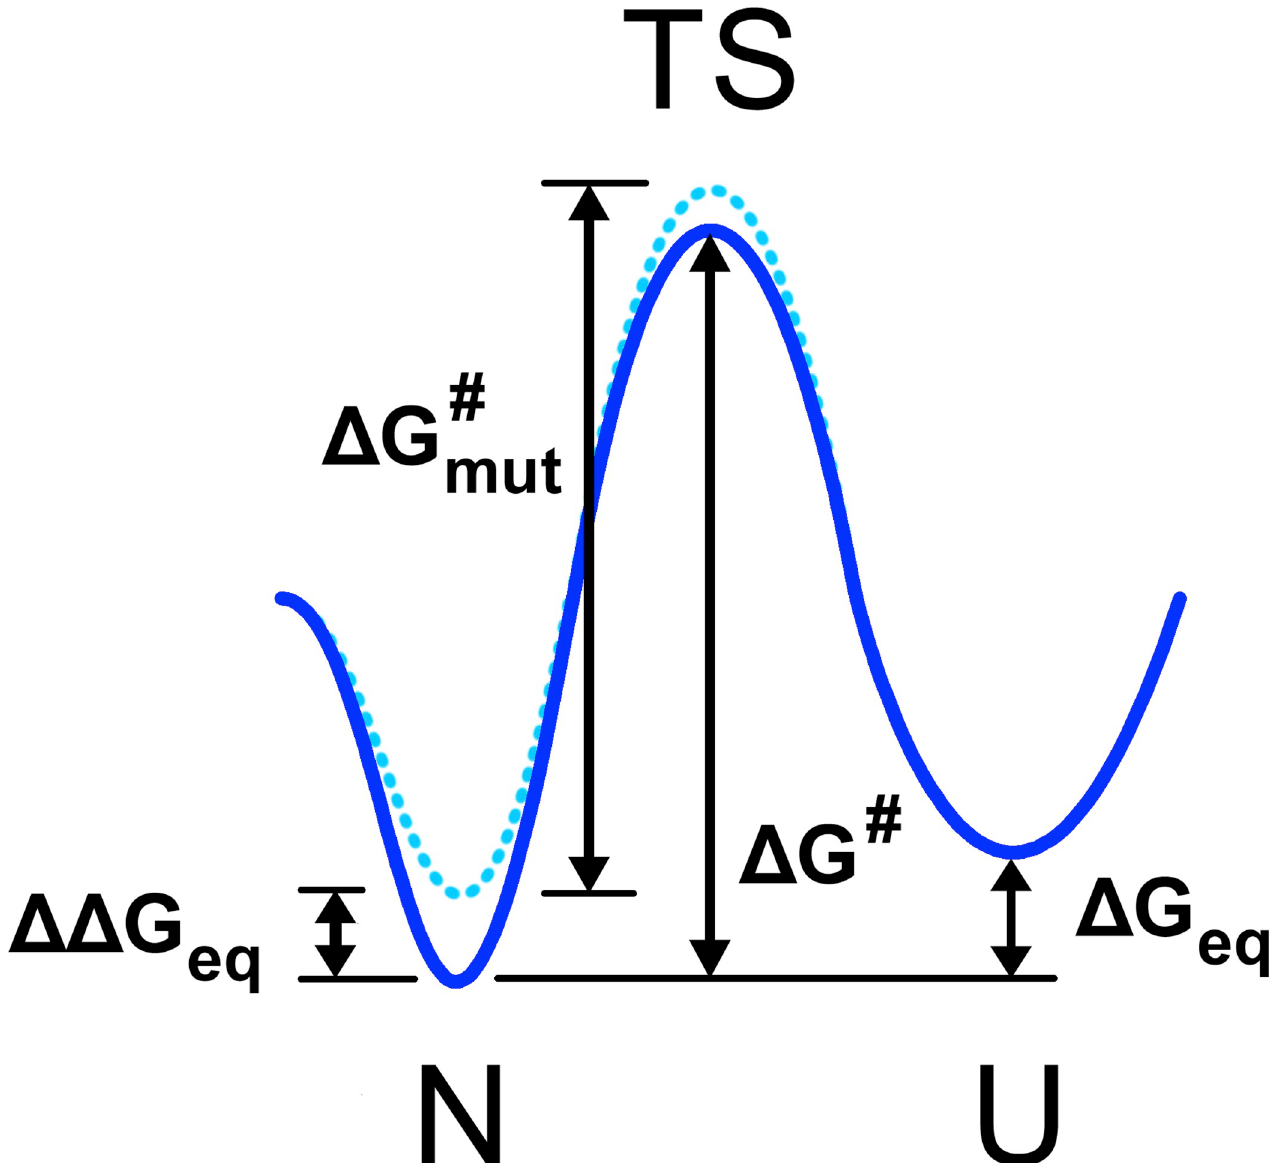
Fig 1. Two state diagram depicting the protein native state N, transition state TS, and unfolded state U. The WT energy landscape is shown in solid blue and the mutant energy landscape in dotted blue. The difference in free energy between WT folded and unfolded states, Δ G eq , the change in this quantity upon , and the height of the transition state barrier relative to the native state for WT ( Δ G # ) and mutant ( D G mutation, ΔΔ G eq